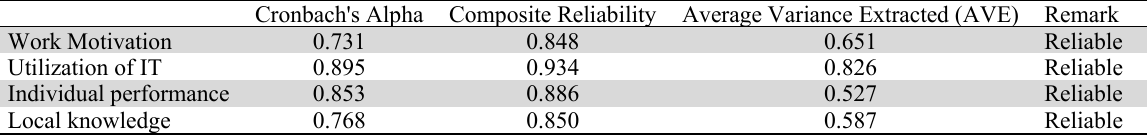
Reliability Test Results